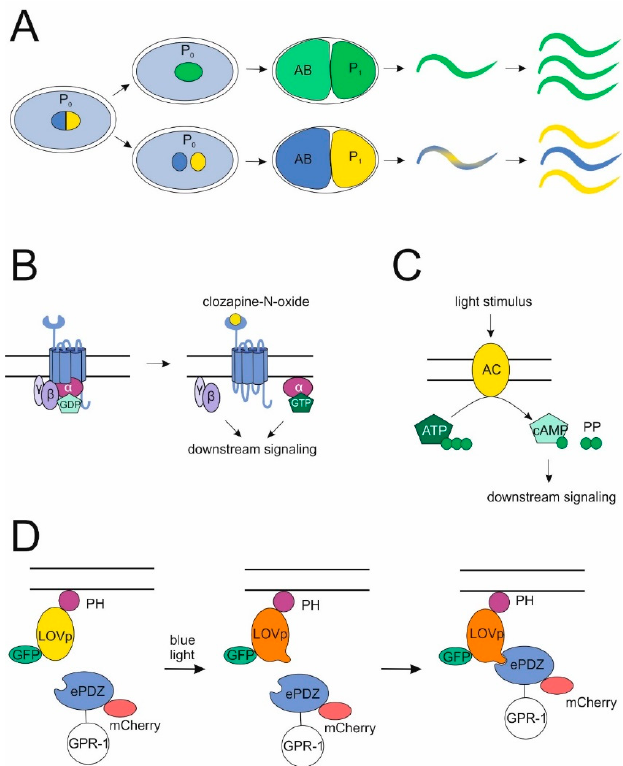
Figure 4. Novel methods for studying G-protein functions. ( A ) Non-mendelian genetic system. By overexpressing gpr-1 in the C. elegans zygote instead of one bipolar spindle, two unipolar spindles are created, which impeaches pronuclear fusion and leads to chimeric embryos. Progeny of these can be genetic replicates of either the mother or the father, depending on which pronucleus localized to the P 1 cell. ( B , C ) Specific induction of G-protein signaling. Distinct G protein cascades can be activated either by stimulating a DREADD, which cannot bind its cognate agonist anymore, with the inert drug clozapine-N-oxide ( B ) or by directly activating downstream effectors of certain G proteins such as an adenylyl-cyclase (downstream of a Gs protein) via photoinduction ( C ). ( D ) The PDZ-LOV-system. Exposure to blue light enables PDZ-tagged cytoplasmic proteins (such as GPR-1) to bind to LOV-domains, which are in parallel tethered to the membrane via a PH-anchor. Fluorescent molecules allow for the control of proper